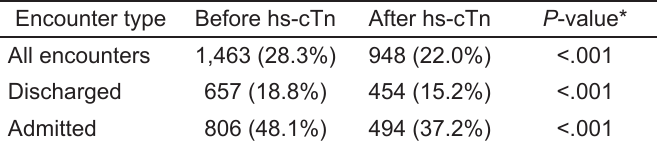
Table 2. Number (%) of ED encounters with troponin ordered before and after hs-cTn introduction.